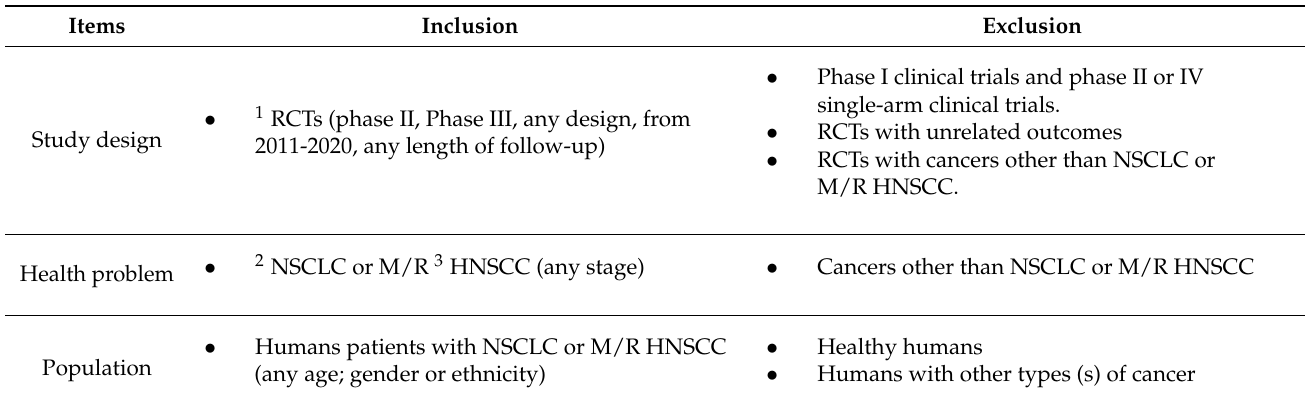
Table 1. Eligibility criteria for secondary records